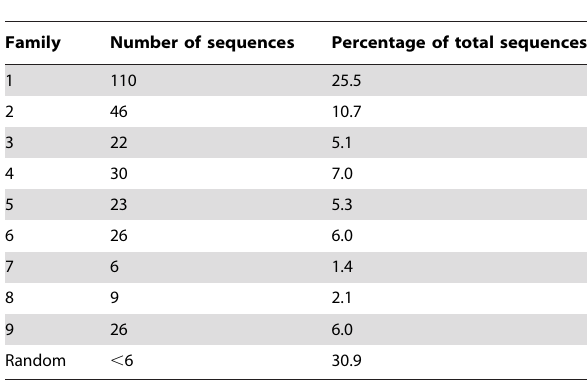
Table 1. Representation of different homologous families after cloning and sequencing and alignment of DLD-1